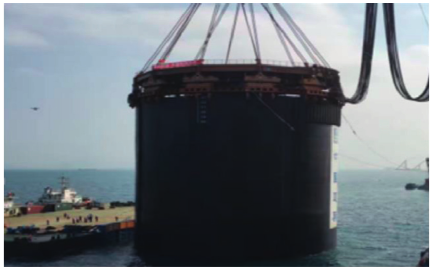
Figure 25: Steel cylinder sinking.